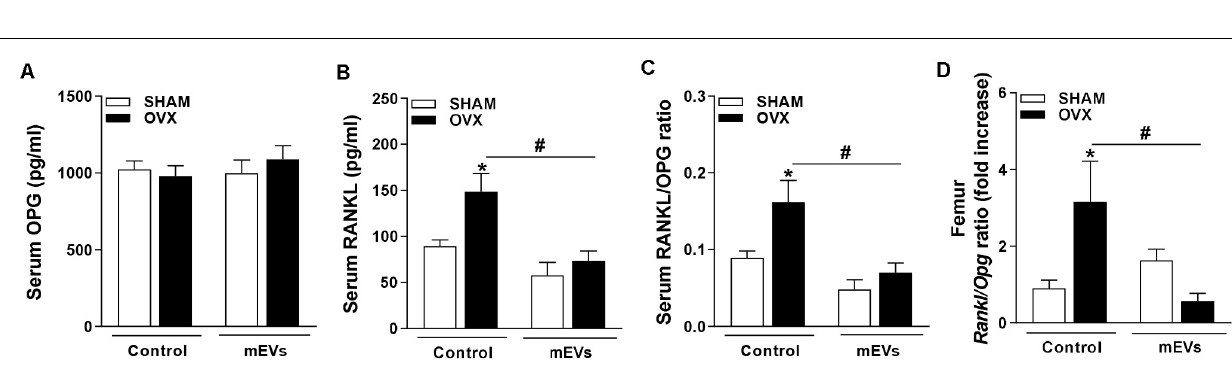
FIGURE 4 | Effect of milk extracellular vesicle treatment on histological analyses of femur and osteoclast differentiation in vitro . (A) Osteoclast number over the bone surface area (N.Oc/BS) and representative histology of distal femur stained with TRAP (40 × and 200 × ). Green arrows indicate osteoclasts. (B) The number of TRAP–positive cells/well and representative images of TRAP–positive cells in the culture (100 × ). Analyses were performed in mice (i) pseudo-operated (SHAM) or (ii) ovariectomized (OVX), (iii) non-treated (control), or (iv) treated with milk extracellular vesicles (mEVs). Values are means ± SEM of 6–8 animals per group. * vs. respective SHAM group and # vs. non-treated group.